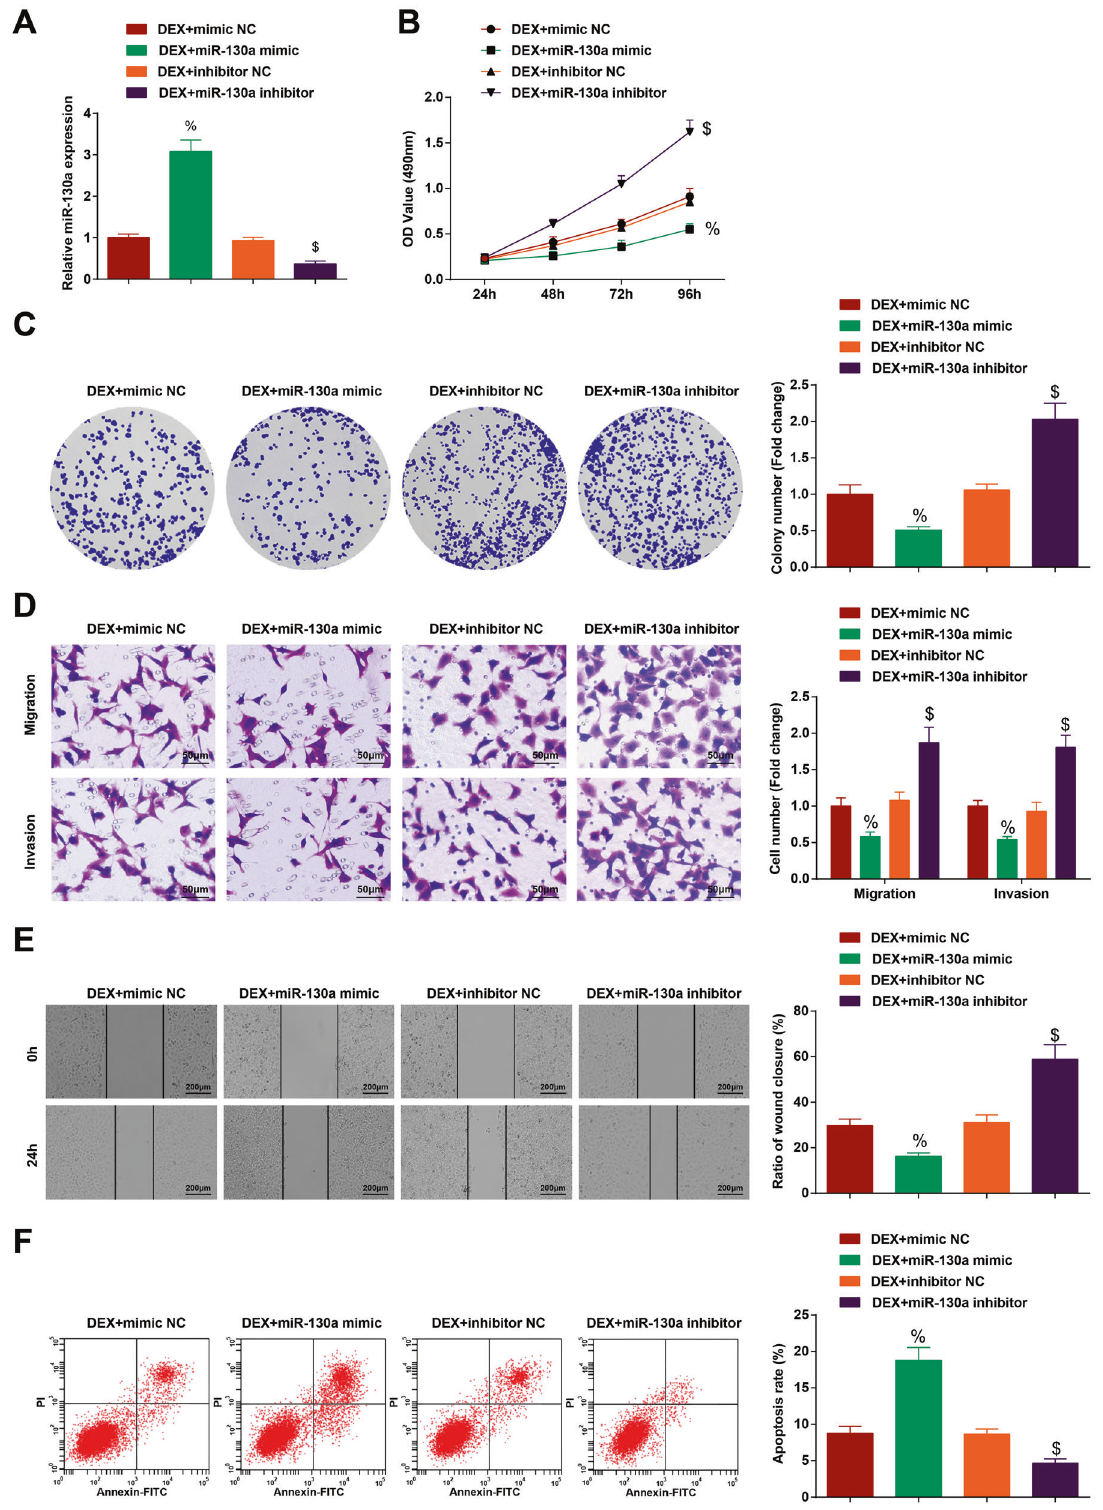
Fig. 5 Elevating miR-130a enhances the inhibitory effects of DEX on HCC. A miR-130a expression tested by RT-qPCR after DEX treatment and upregulating miR-130a; B OD value tested by MTT test after DEX treatment and upregulating miR-130a; C Colony-forming ability of HCC cells tested by colony formation assay after DEX treatment and upregulating miR-130a; D Migration and invasion of HCC cells tested by Transwell test after DEX treatment and upregulating miR-130a (scale bar = 50 μ m); E Migration distance of HCC cells tested by scratch test after DEX treatment and upregulating miR-130a (scale bar = 200 μ m); F Apoptosis of HCC cells tested by fl ow cytometry after DEX treatment and upregulating miR-130a. N = 3. The data were expressed as mean±standard deviation and compared by one-way ANOVA. % p < 0.05 vs. the DEX + mimic NC group; $ p < 0.05 vs. the DEX + inhibitor NC group.